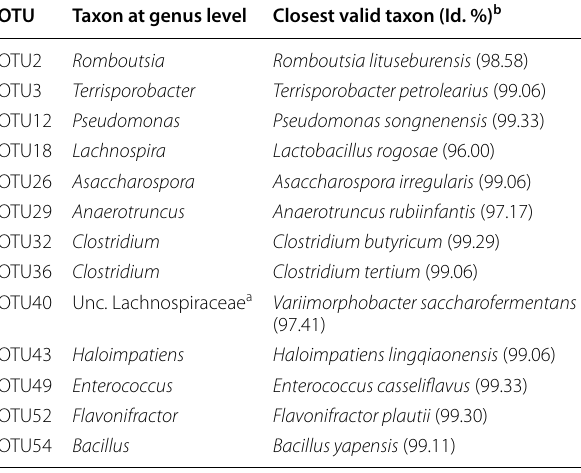
Table 2 Taxonomic affiliations of the most abundant (> 1%)